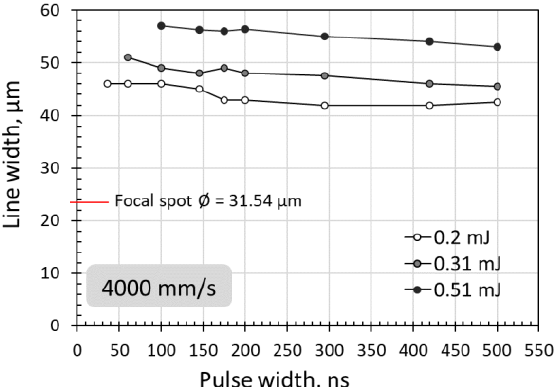
Figure 11. Surface morphologies showing a stronger edge thermal effect and more debris along the scanning line at increasing pulse energy fluence at 400 mm/s scanning speed.